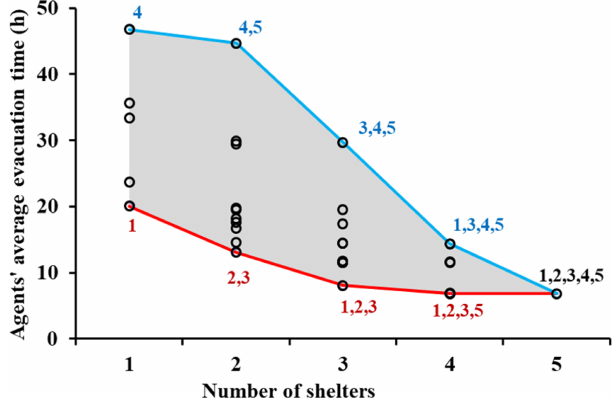
Figure 9. The average evacuation time of residents under the sce- narios that consider all of the possible combinations of the five op- tional evacuation shelters.